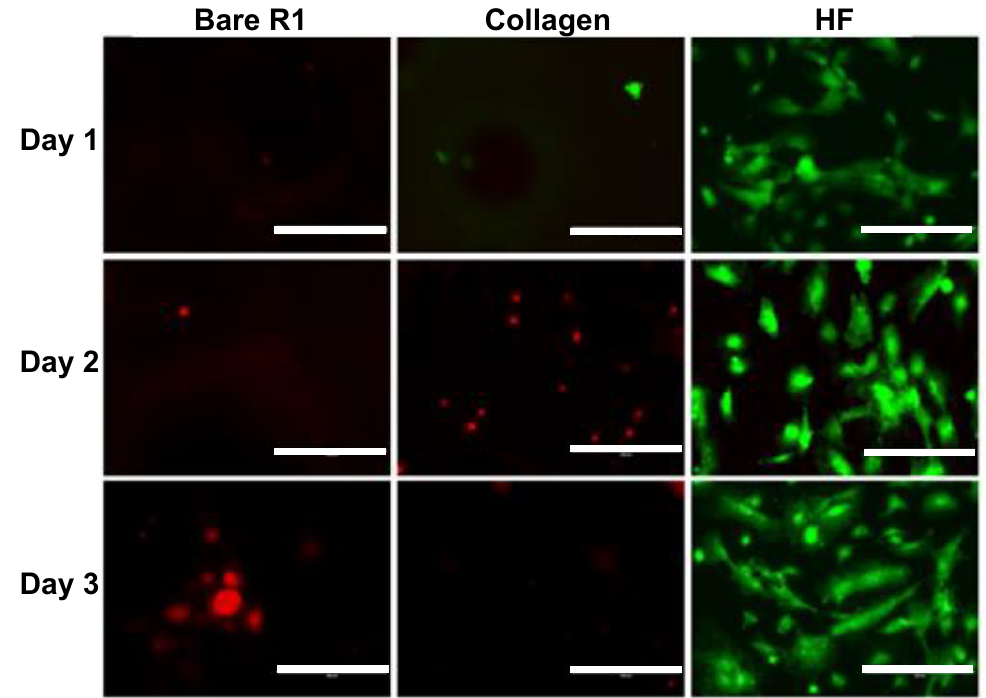
Figure 7. Endothelial cells cultured on bare R1, collagen coated R1 and HF treated R1 alloys from day 1 to day 3 (Scale bar: 10 µm).